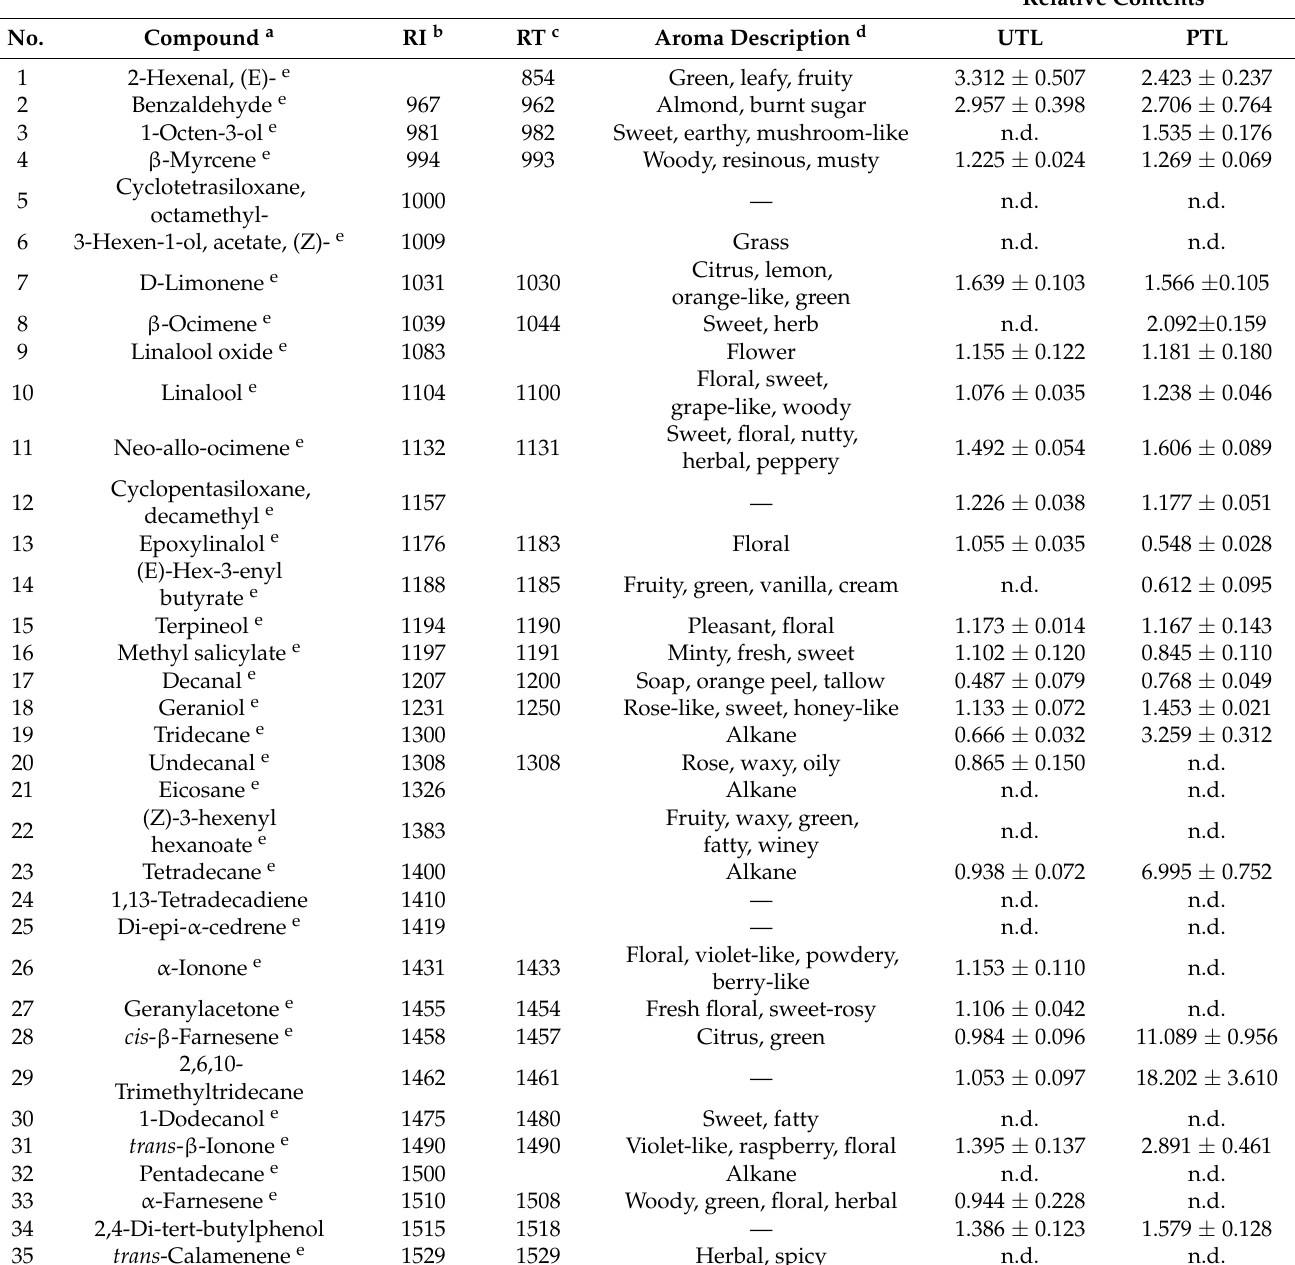
Table 1. Volatile compounds in PTL and